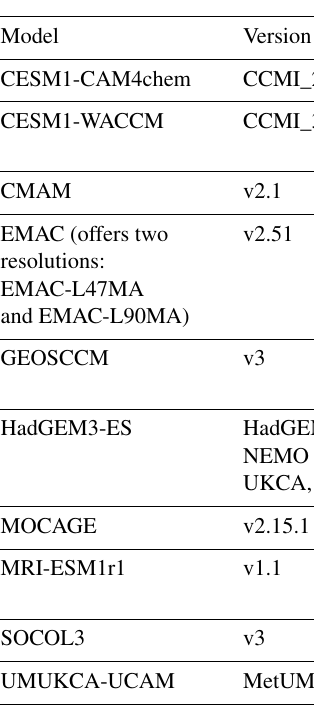
Table 1. List of CCMI models included in this study with model versions and references ∗ .